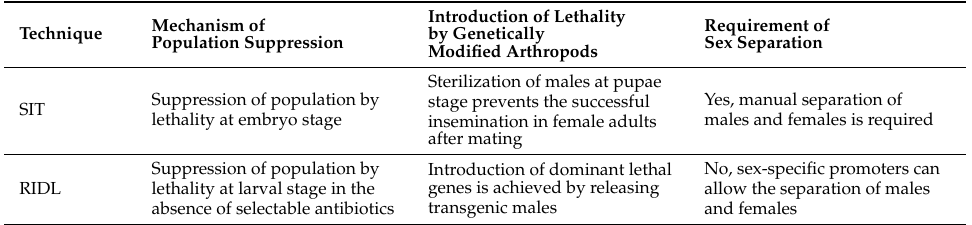
Table 2. Comparison of sterile insect technique (SIT) and release of insects with dominant lethality